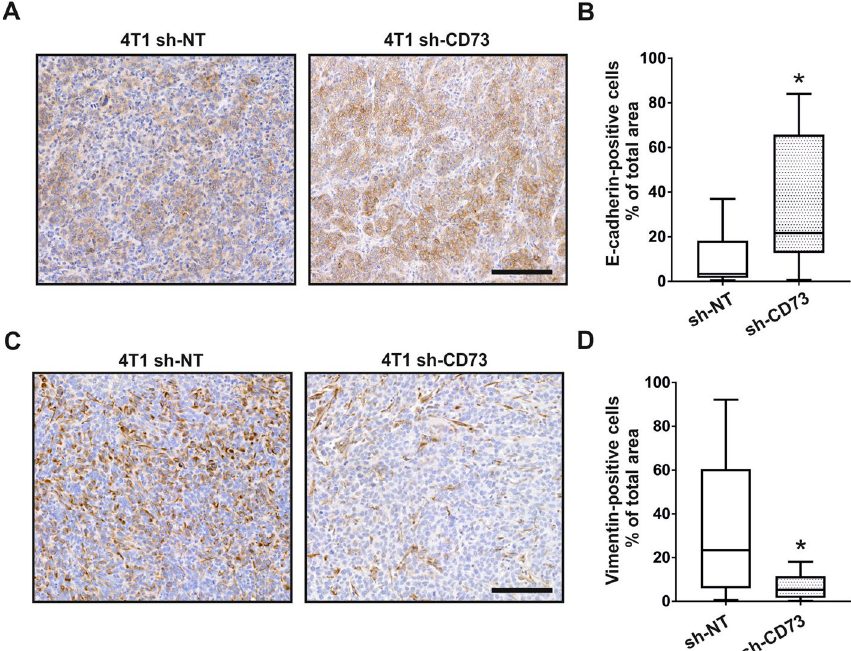
Figure 6. CD73 suppression enhances E-cadherin expression and inhibits vimentin expression in vivo. ( A ) Representative images of E-cadherin-positive cells in sh-NT and sh-CD73 tumors. Scale bar 200 µm. ( B ) Percentage of E-cadherin-positive cells from 4T1 sh-NT and sh-CD73 tumors. ( C ) Representative images of vimentin-positive cells in sh-NT and sh-CD73 tumors. Scale bar 200 µm. ( D ) Percentage of vimentin-positive cells from 4T1 sh-NT and sh-CD73 tumors. For each staining, the expression was quantified using QuPath. Data is expressed as mean ± SEM, *P < 0.05; sh-CD73 vs. sh-NT tumors, by a two-tailed Student’s